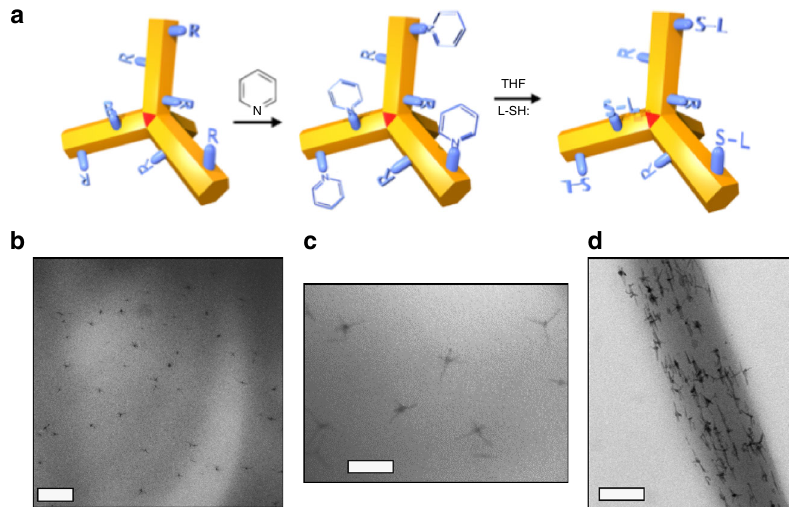
Fig. 2 Singly dispersing tQDs into polymers. a Schematic of the two-step process to coat tQDs with thiol-terminated polymers. b , c TEM images of PLLA- coated tQDs in PLLA polymer. c Closer view. d TEM image of PLLA-coated tQDs in PEO fi ber. Scale bars are b 200 nm; c 40 nm; and d 80 nm